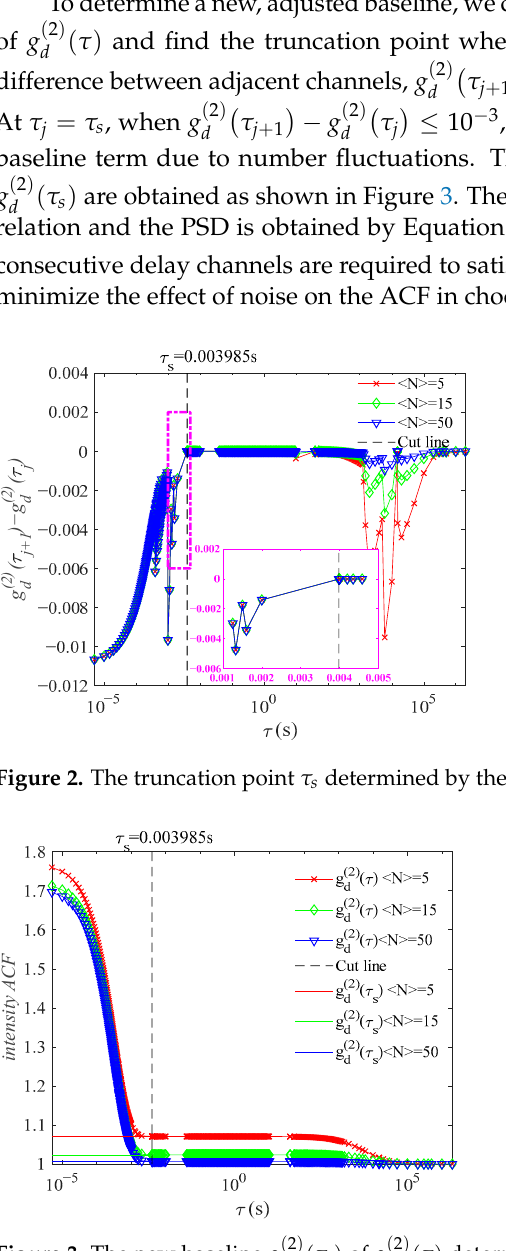
Figure 3. The new baseline g